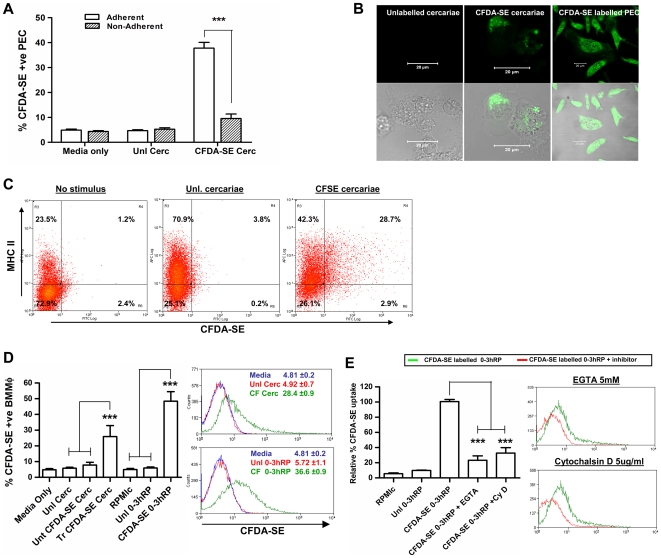
Material released by CFDA-SE-labelled cercariae is phagocytosed by adherent MHC-II+ cells.A; Uptake of the labelled material in adherent cells is significantly greater than non-adherent cells; (p<0.001). B; Representative fluorescent, and merged with brightfield, images of adherent PECs exposed to unlabelled or CFDA-SE labelled cercariae, or directly to free CFDA-SE. C; Cells that take up ES material expressed elevated levels of MHC-II and 40.4% of these were also positive for CFDA-SE. All results for PEC are representative of 5 independent experiments. D; Fluorescence of BMMФ stimulated with unlabelled or CFDA-SE labelled cercariae, or unlabelled or CFDA-SE labelled 0-3hRP with flow cytometry histogram plots displaying MFI (Unl Cerc = unlabelled cercariae, Unt CFDA-SE Cerc = untransformed labelled cercariae, Tr CFDA-SE Cerc = transformed labelled cercariae, RPMIc = concentrated RPMI, 0-3hRP = 0-3 hour released preparation). E; Addition of EGTA (5 mg/ml) or Cytochalasin D (10 ug/ml) significantly decreased uptake of CFDA-SE 0-3hRP. Representative plots are shown, bars are means±SEM where n = 6 mice.